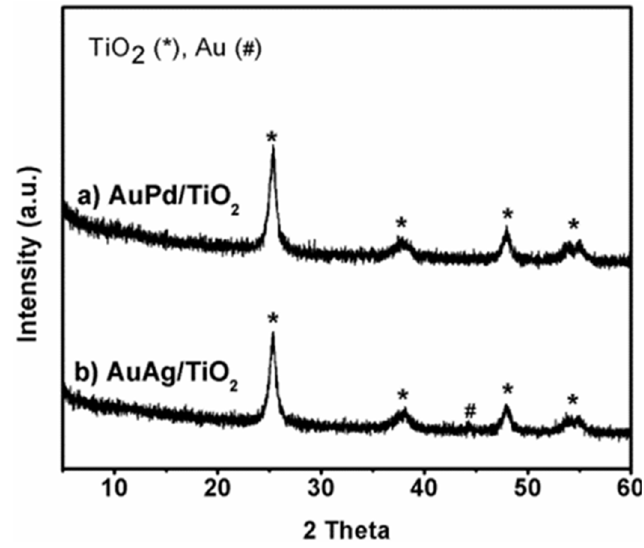
Figure 10. XRD patterns of different bimetallic catalysts ( a : AuPd/TiO 2 ; b : AuAg/TiO 2 ).